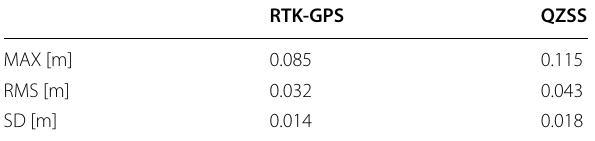
Table 2 Differences between the positions obtained using the GNSS with wheel odometry and the robotic